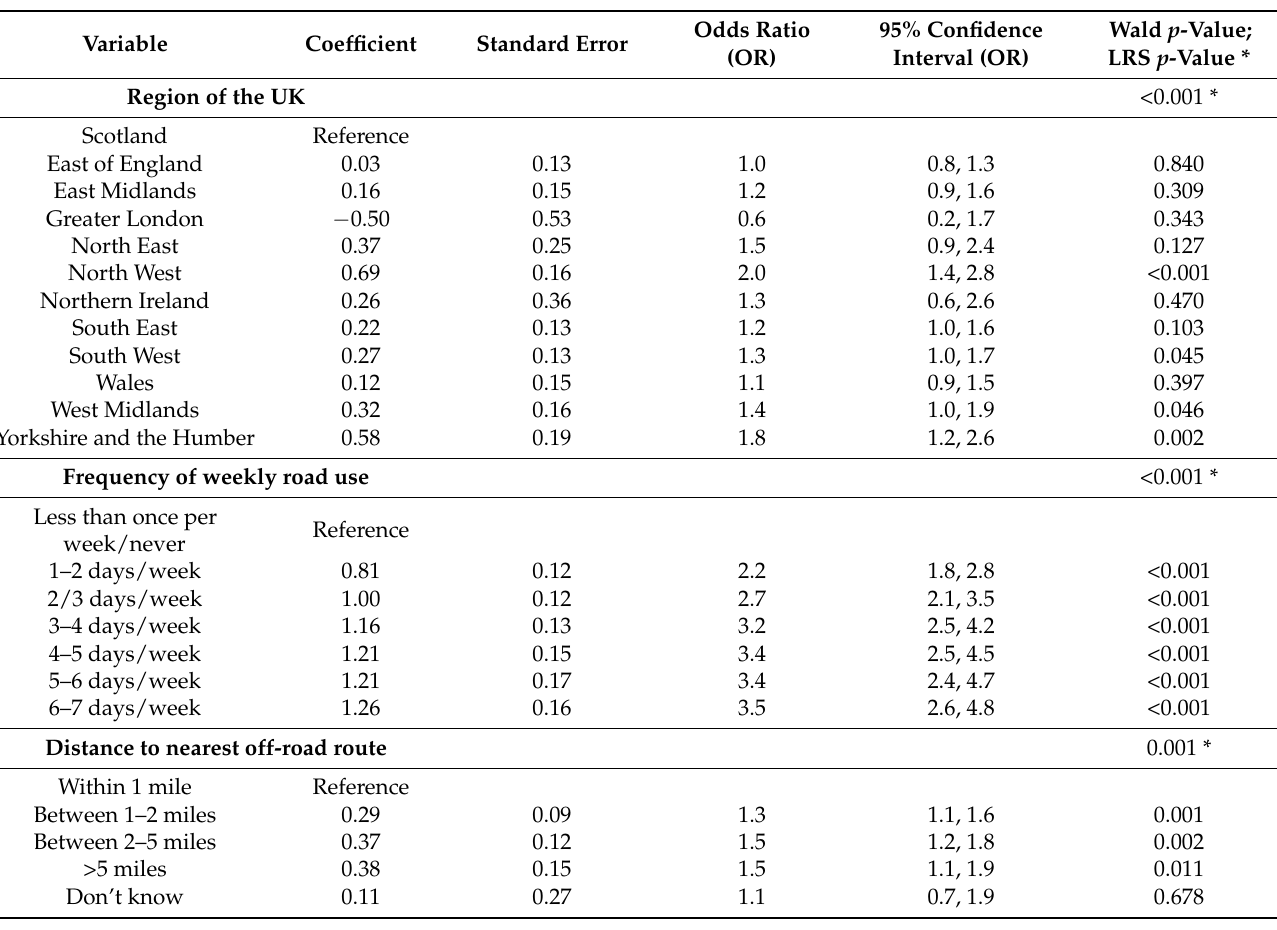
Table 5. Multivariable logistic regression modelling to identify factors associated with higher odds of having had a road- related near-miss while using roads with a horse in the previous year (based on responses from 4842 UK equestrians in October